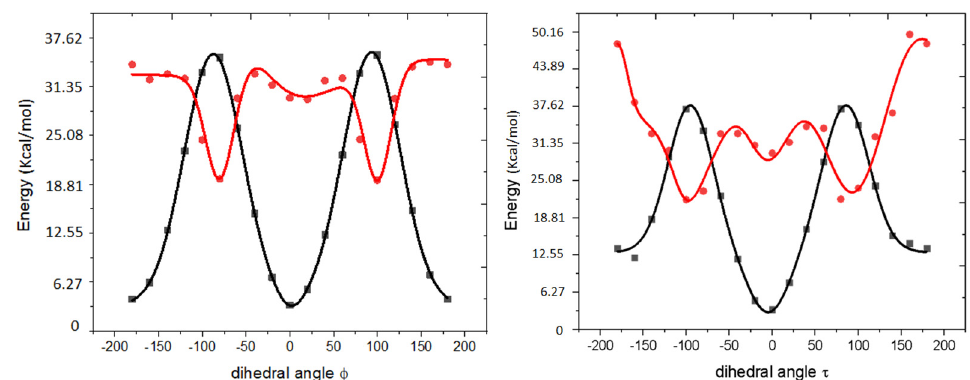
Figure 7. PES scans (relative energies) for the isolated GYG chromophore along the dihedral angles φ ( left ) and τ ( right ) in the ground (black) and electronically excited (red) states. All other degrees of freedom are frozen. The dots represent ab initio calculations ( ω B97X-D / aug-cc-pvDZ) and the solid lines are fits to the force-field torsional potential used in molecular dynamics simulations (see Section 4.6). In contrast to the isolated chromophores, the protein-bound excited chromophores can only undergo phenolate flip ( φ twist) because the imidozalinone ring is covalently bound to the protein backbone.